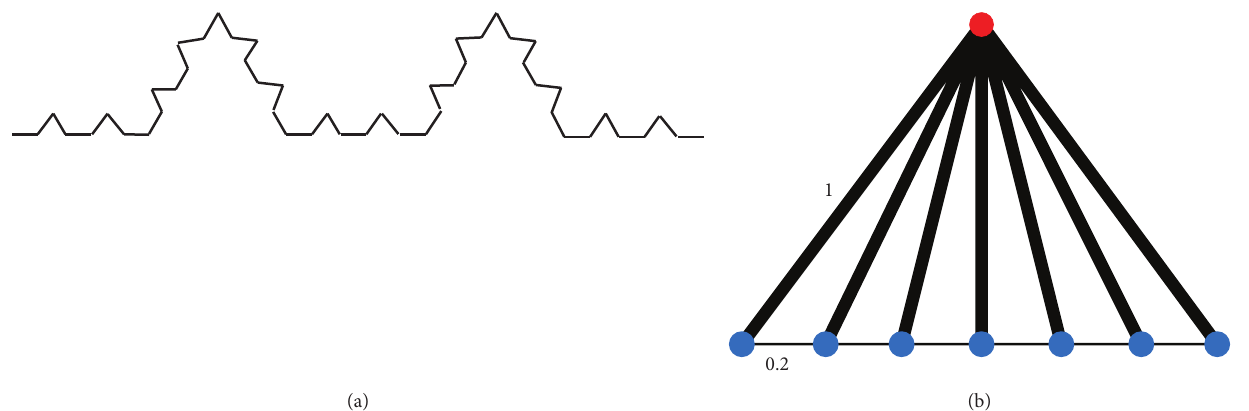
Figure 3: (a) The first two generations of the construction for the generalized Koch curve with p � 2. (b) The initial weighted graph G